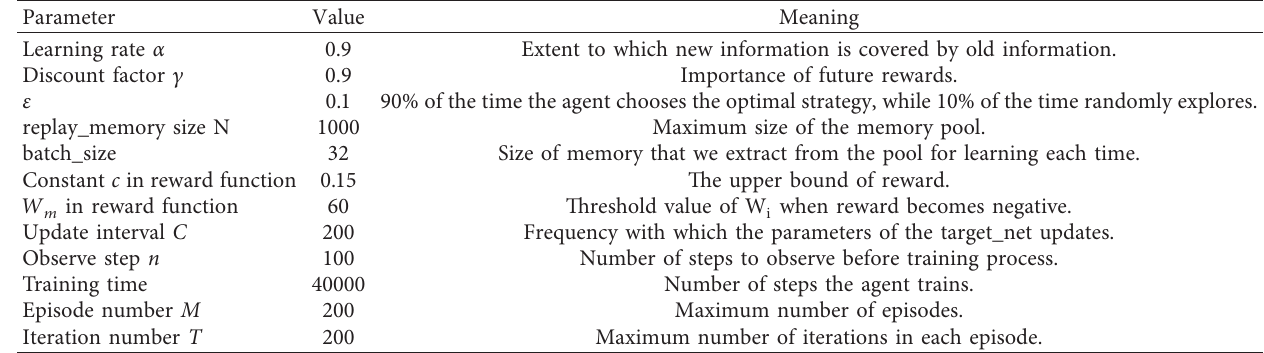
Figure 9: Coordination of simulated traffic network: (a) single-intersection case; (b) four-intersection Table 1: Parameter settings for the model.